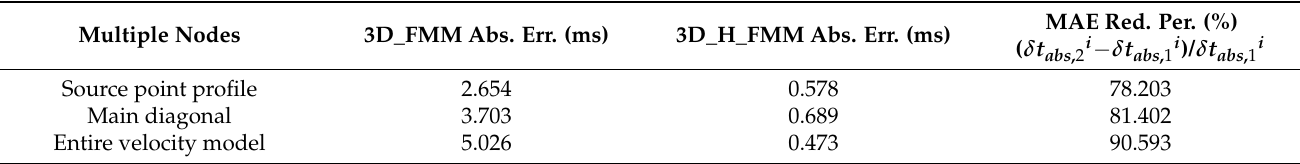
Table 6. The MAE of the travel time calculated by 3D_H_FMM and 3D_FMM at multiple nodes in the Case B: large-scaled homogeneous